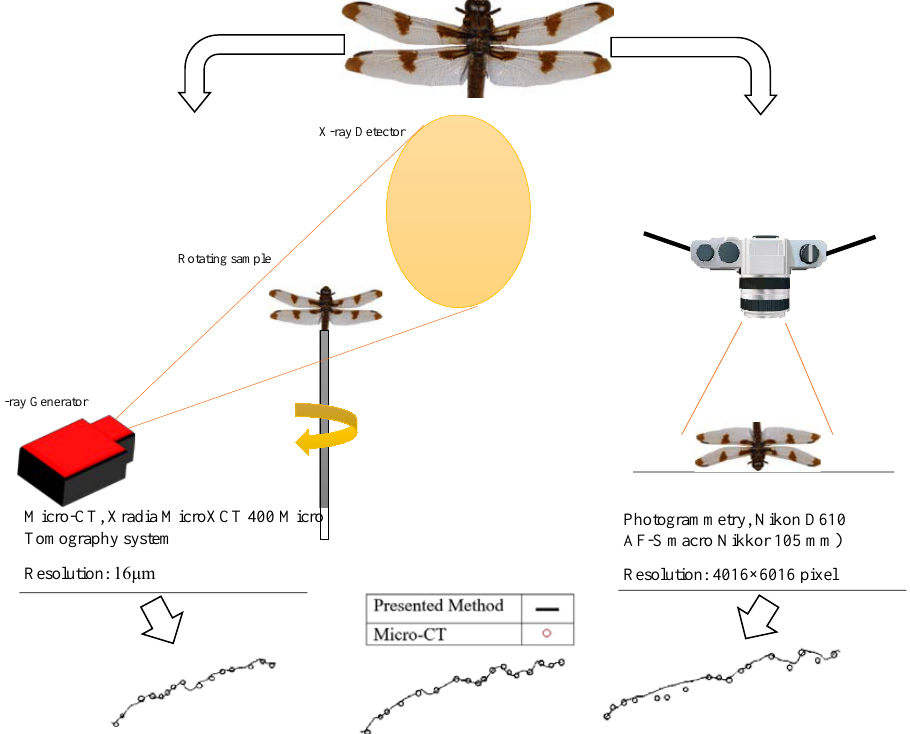
Figure 4. Schematic view of photogrammetry and Micro-CT process.